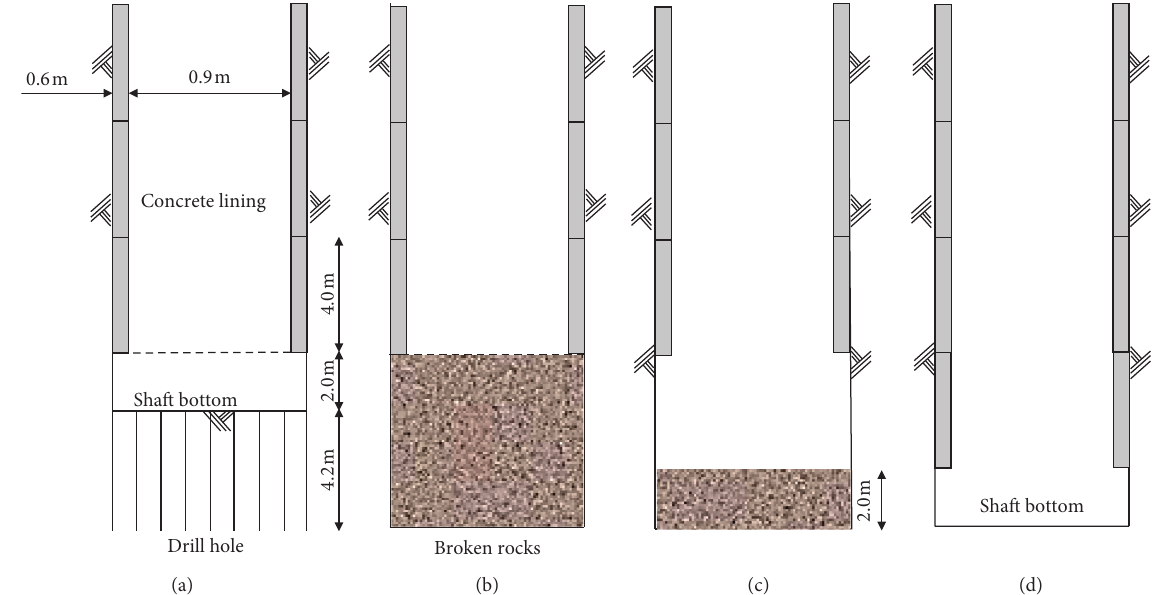
Figure 4: Shaft sinking procedure using the short-step method. (a) Stage 1. (b) Stage 2. (c) Stage 3. (d) Stage 4.